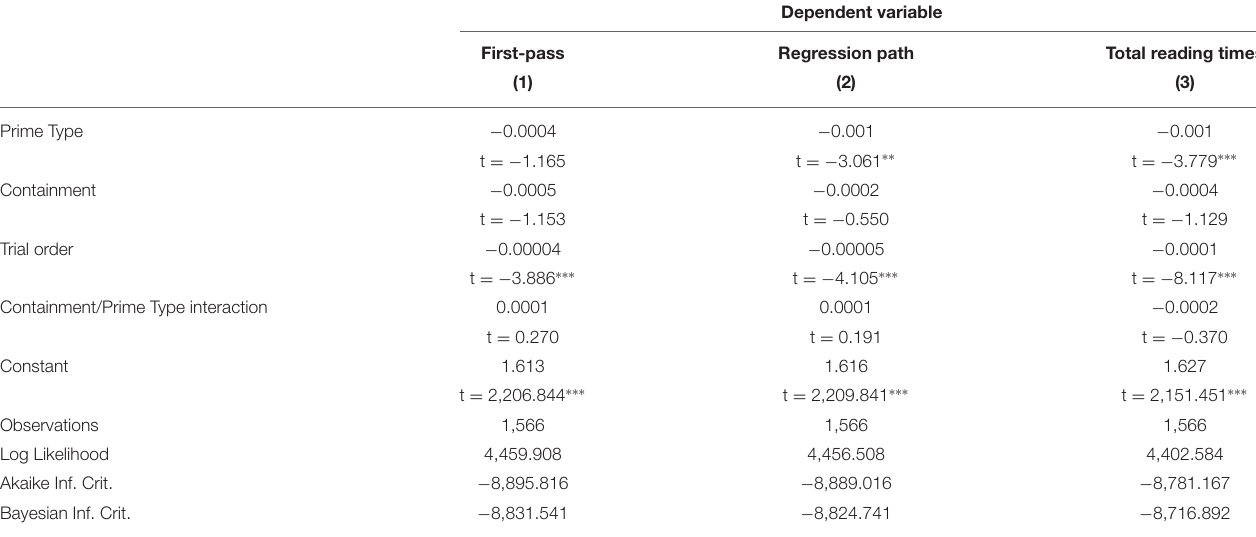
TABLE 9 | Regression analysis of reading times in the VERB region of Experiment 2.